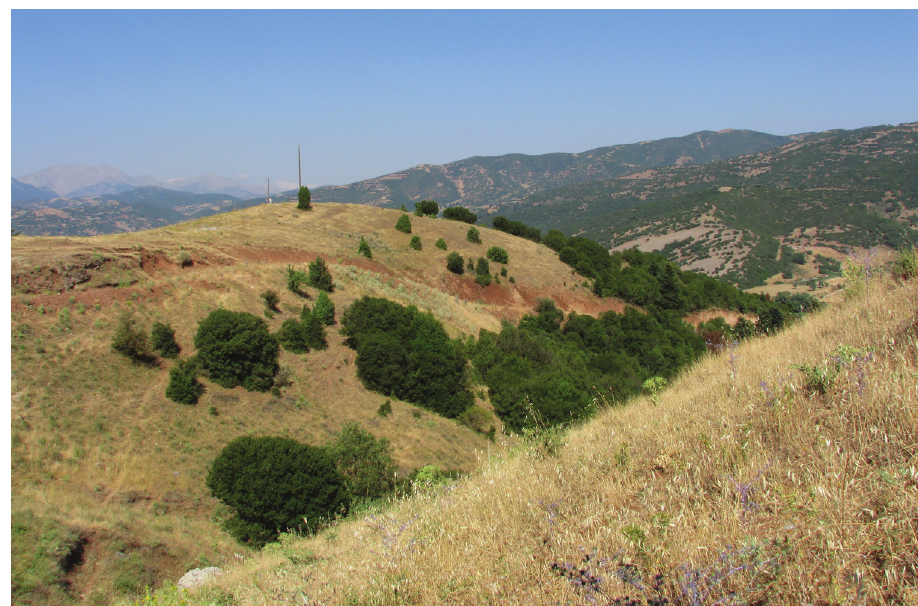
Figure 27. Habitat of P. ripartii pelopi . Greece, Peloponnesse Peninsula, Mt. Chelmos, near Kalavrita, 800 m, 17 July 2008. Photo by V.A.